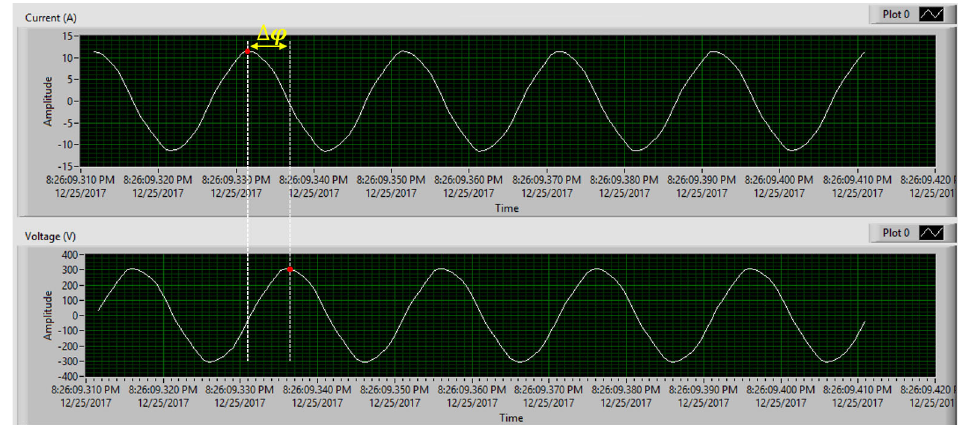
Figure 10. System calibration using a 2 kW resistive